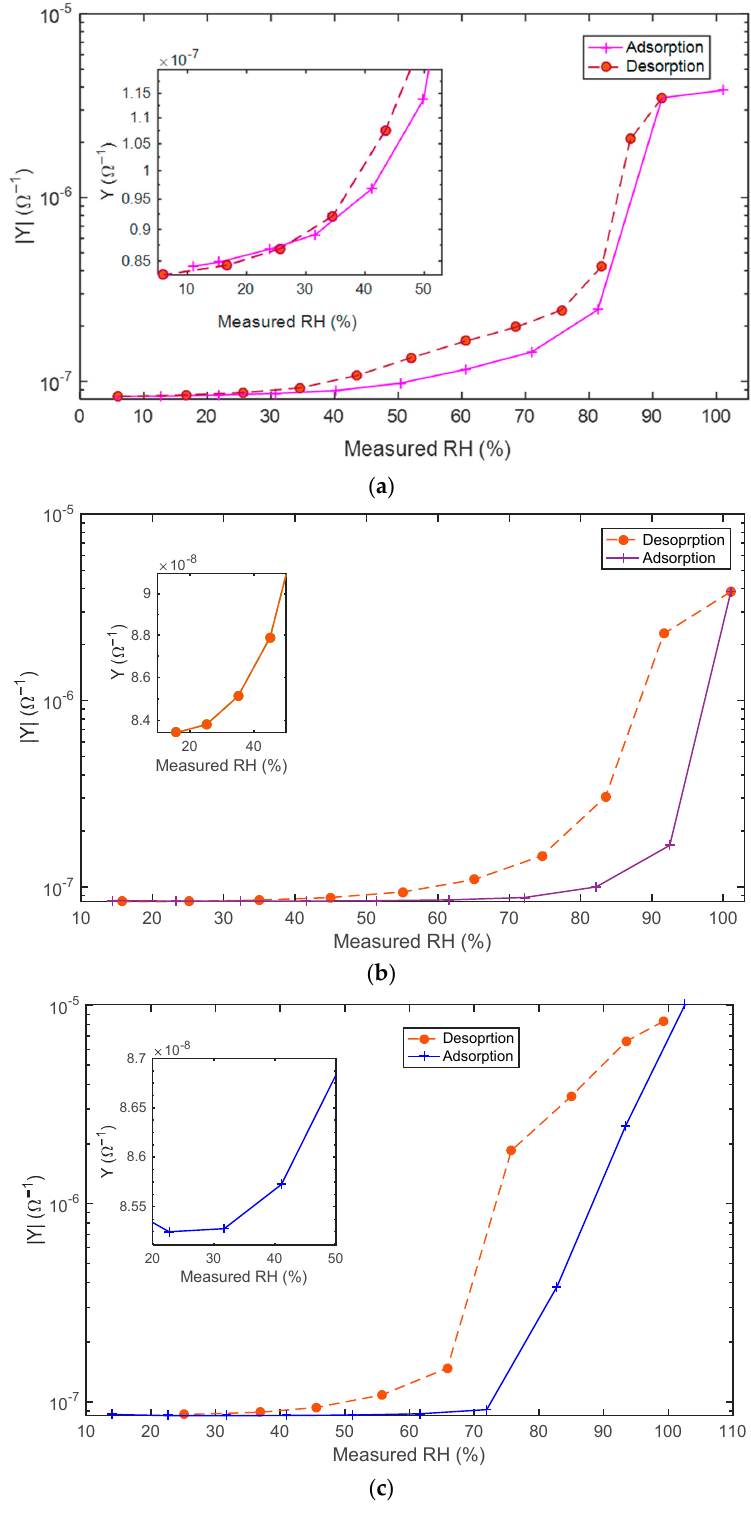
Figure 13. Measured sensing film admittance magnitude at 100 Hz as a function of the RH value measured with the commercial sensor in the measurement chamber for increasing (10–100%) and decreasing (100–10%) RH levels: ( a ) TiO 2 sample; ( b ) TiO 2 Au1 sample; ( c ) TiO 2 Au2 sample.